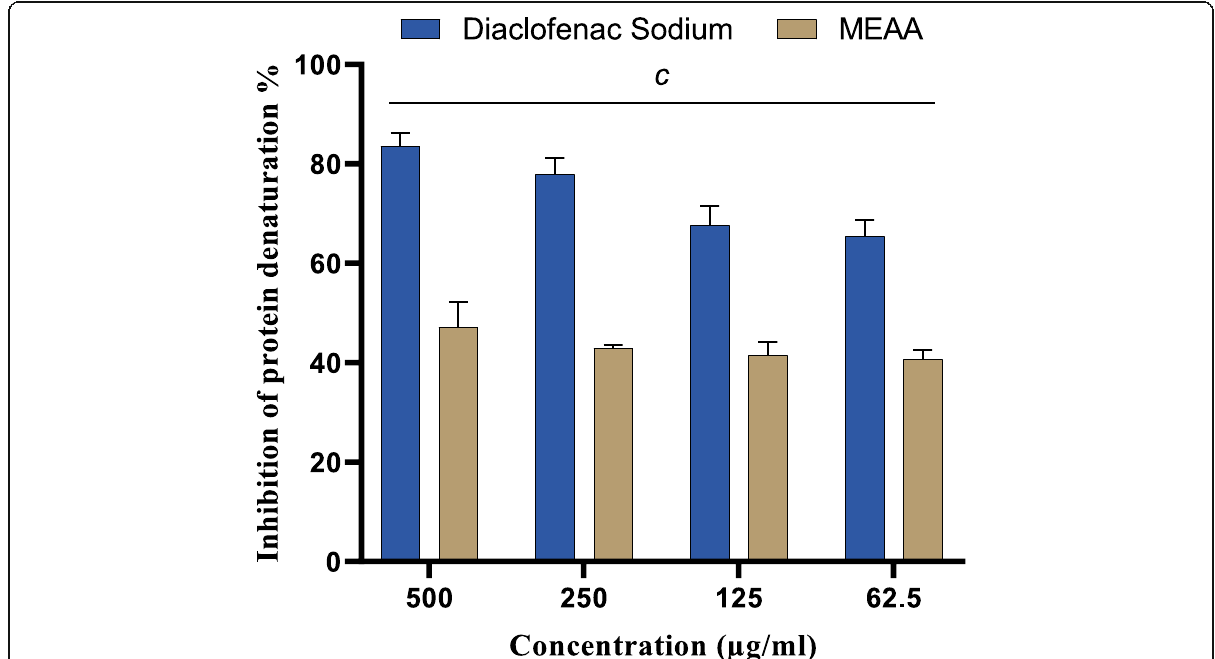
Fig. 2 Percentages of egg albumin protein denaturation by methanol extract of methanol leaves extract of A . auriculiformis (MEAA) and standard drug diclofenac sodium. Values are mean ± SEM ( n = 3). c p < 0.001, significantly different from control followed by Dunnett ’ s test